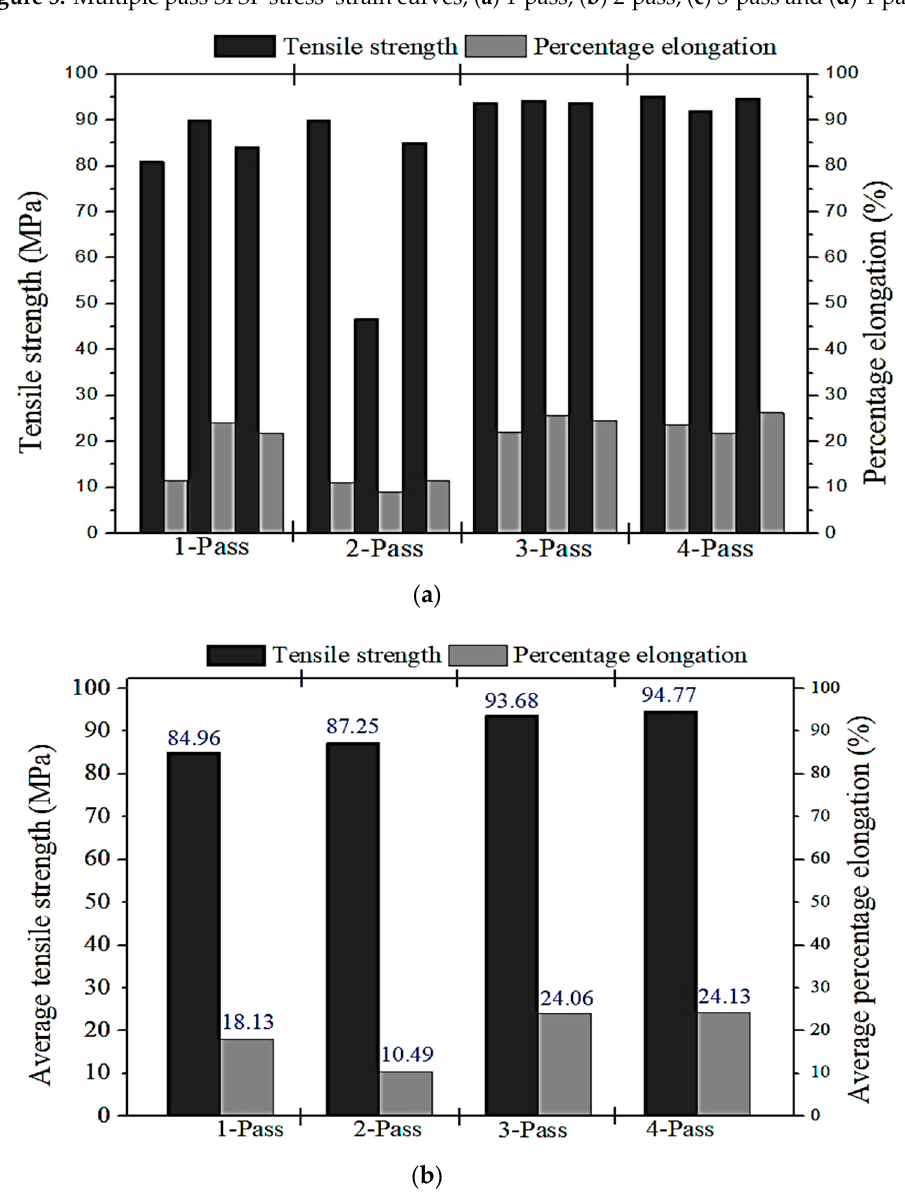
Figure 6. ( a ) Multiple pass SFSP tensile strength and percentage elongation, ( b ) average multiple pass SFSP tensile strength and percentage elongation.